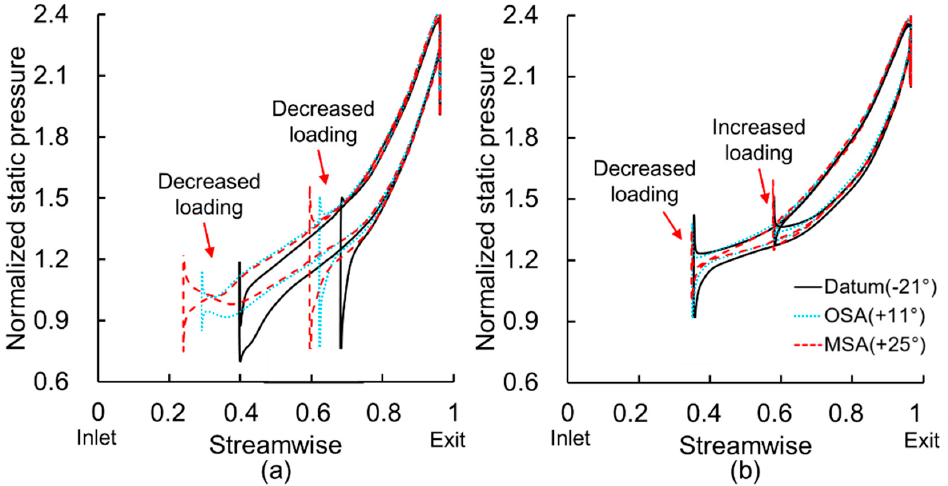
Figure 15. Static pressure distribution of splitters at ( a ) 95% span and ( b ) 5% span.